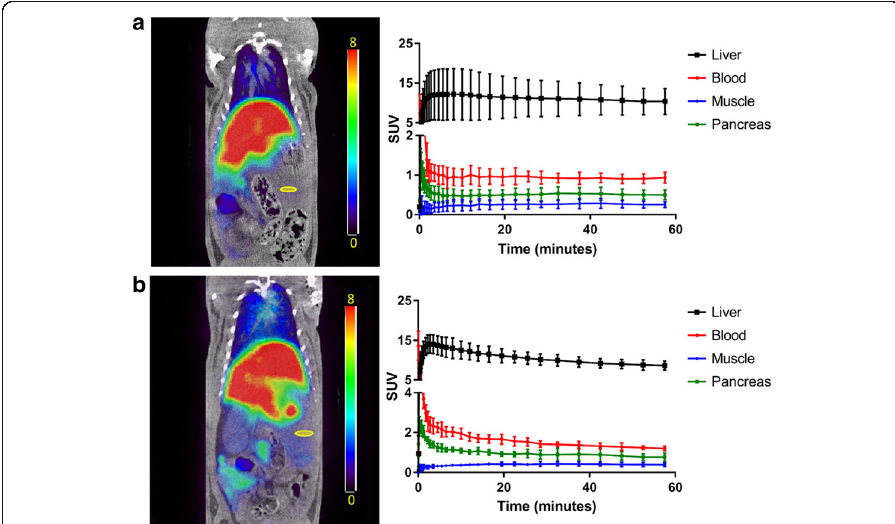
Fig. 2 Representative microPET images (SUV, sum of all frames; pancreas ROI shown in yellow) with tissue time-activity curves in rats following injection of ( a ) [ 18 F]7 and ( b ) [ 18 F]7 with a pre-injection of TAK-875 (30 mg/kg). Time-activity curve data are presented as average SUV ± standard deviation ( n =